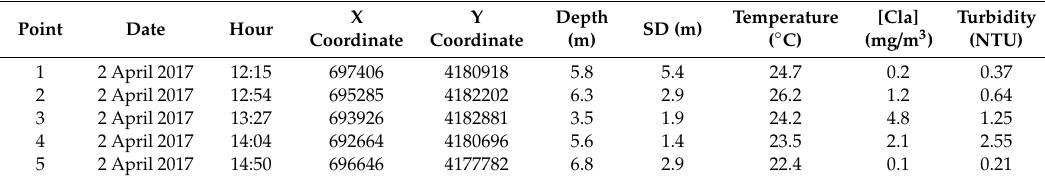
Table 1. Field data recorded on 2 April 2017 in five point samplings. Hours in Central European Time; coordinates in Universal Transverse Mercator system; depth of sampling point; SD, transparency measured as Secchi Disk depth